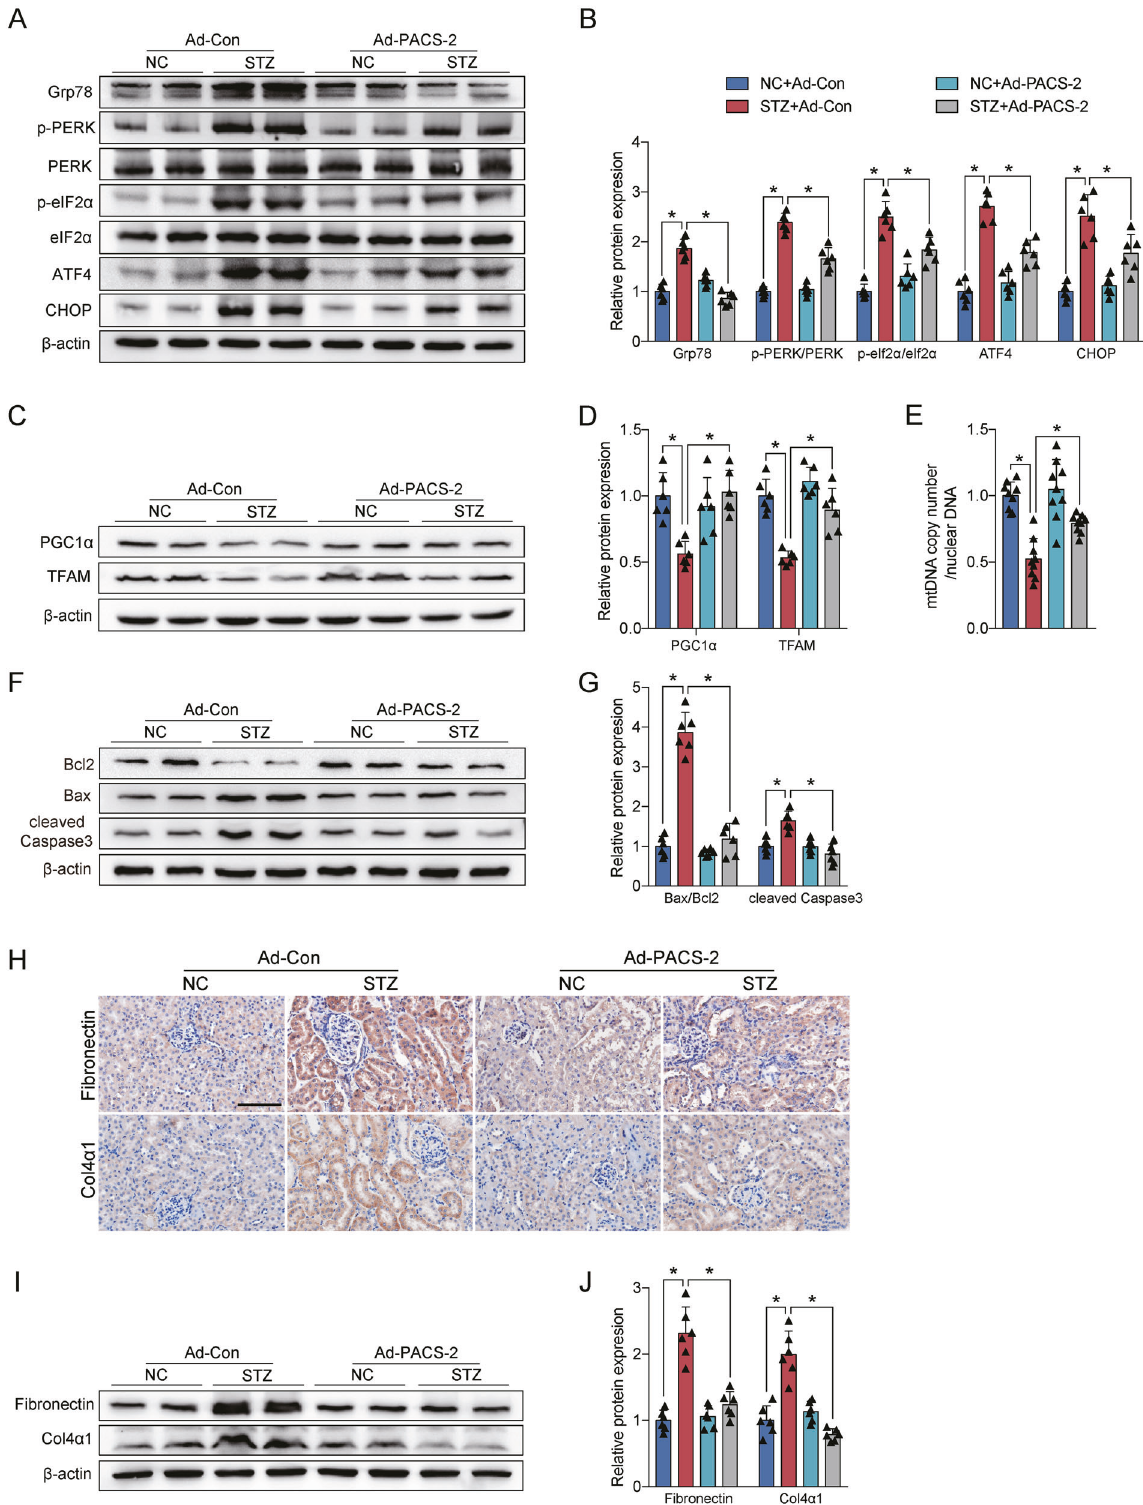
Fig. 5 PACS-2 restoration attenuated ER stress, mitochondrial dysfunction, apoptosis, and fi brosis in diabetic kidneys. A Western blot bands of Grp78, p-PERK, PERK, p-eIF2 α , eIF2 α , ATF4, and CHOP in kidney lysates. B Quantitative analysis of indicated protein levels in A . n = 6. C Western blot bands of TFAM and PGC1 α in kidney lysates. D Quantitative analysis of indicated protein levels in C . n = 6. E Measurement of mtDNA copy number normalized to nuclear gene. n = 9. F Western blot bands of Bax, Bcl2, and cleaved Caspase3 in kidney lysates. G Quantitative analysis of indicated protein levels in F . n = 6. H Immunohistochemical staining of Fibronectin and Col4 α 1 in the kidney sections. Scale bar = 100 μ m. I Western blot bands of Fibronectin and Col4 α 1 in kidney lysates. J Quantitative analysis of indicated protein levels in I . n = 6. All data are expressed as mean ± SD. * P <